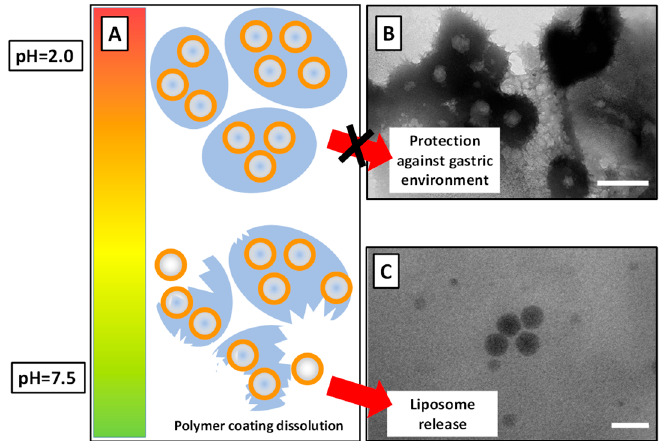
Figure 1. Sketch illustrating the behavior of Eu-curc-liposomes with increasing pH, up to the dissolution of the polymeric coating ( A ). Transmission electron microscopy (TEM) micrograph of Eu-curc-liposomes at pH 5.0. Scale bar: 200 nm ( B ). TEM micrograph of Eu-curc-liposomes at pH 7.5. Scale bar 100 nm ( C ).